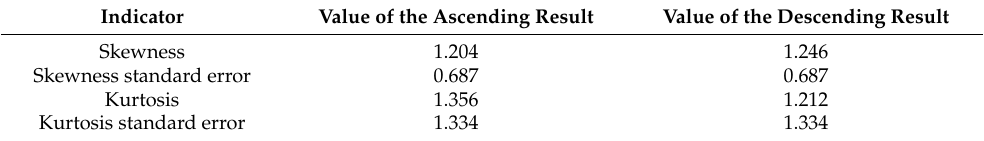
Table 3. Skewness and kurtosis of ascending results.